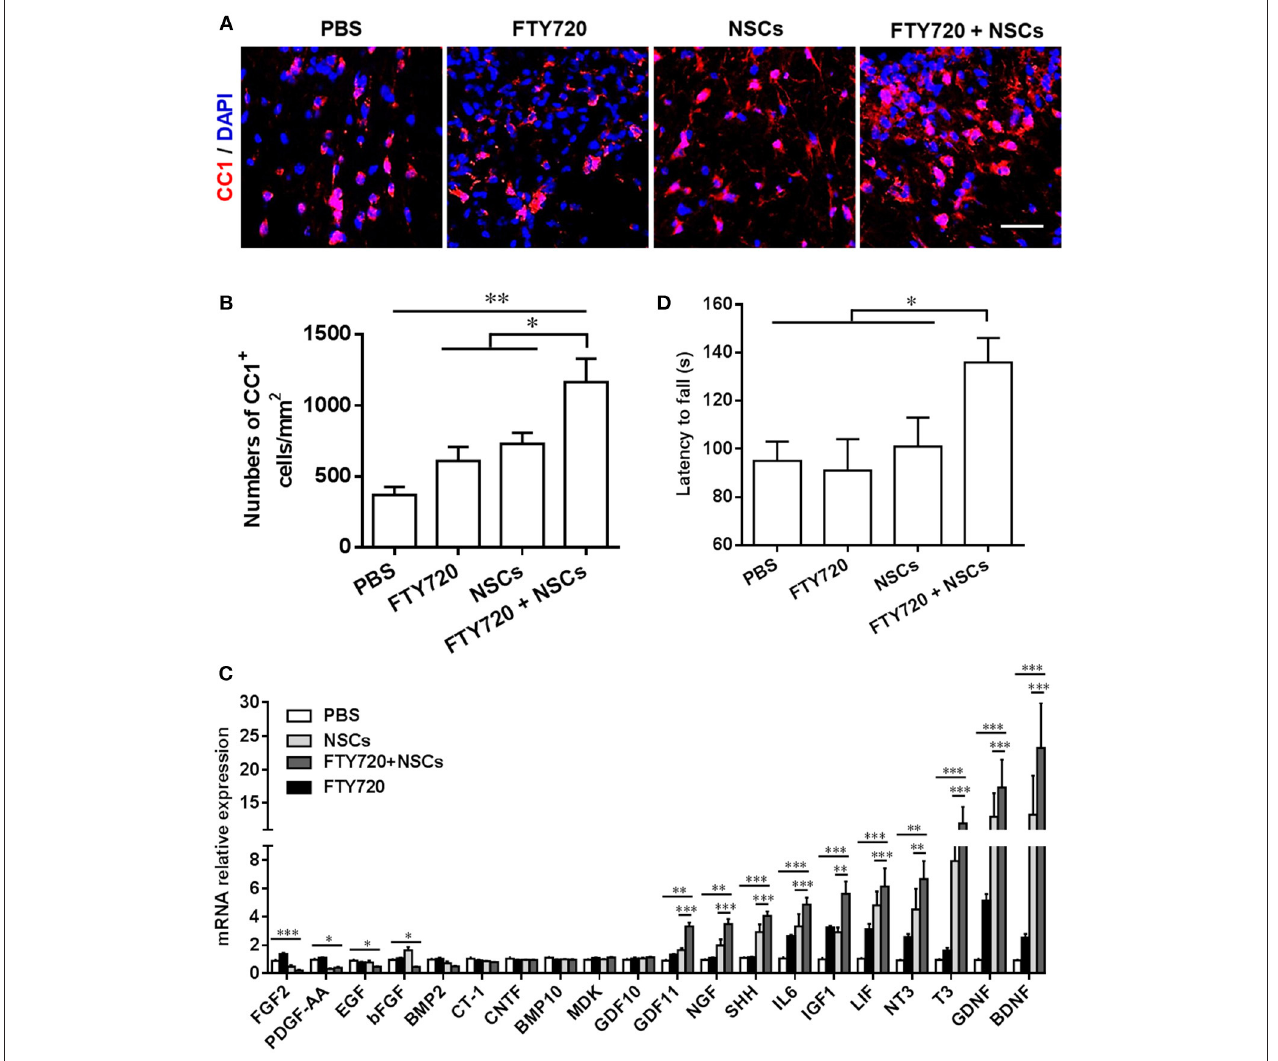
FIGURE 4 | The effect of co-treatment with FTY720 and NSCs on the number of mature oligodendrocytes in the spinal cord of newborn mice. Spinal cords of mice described in Figure 3 were harvested at day 14 postnatal, and lumbar sections were stained for newly matured oligodendrocyte marker CC1. (A) Representative confocal images displaying CC1 + (red) immunoreactivity at day 14 postnatal. Scale bar = 10 µ m. (B) Quantification of total CC1 + cell numbers. (C) Expression of growth factor genes in brain tissues was determined using Custom RT ² Profiler TM PCR Array Mouse Growth Factors (Qiagen, Valencia, CA). Relative expression was calculated by – 11 Ct values from triplicate of PCR ( n = 3; mean + SEM, Student’s t -test; normalized to PBS group). (D) The effect of postnatal FTY720 or/and NSC administration on the performance of newborn mice in accelerating rotating rod test was examined at day 21 postnatal. Symbols represent mean ± SD. * p < 0.05, ** p < 0.01, *** p < 0.01. One-way ANOVA with Tukey’s multiple comparisons test and unpaired Student’s t